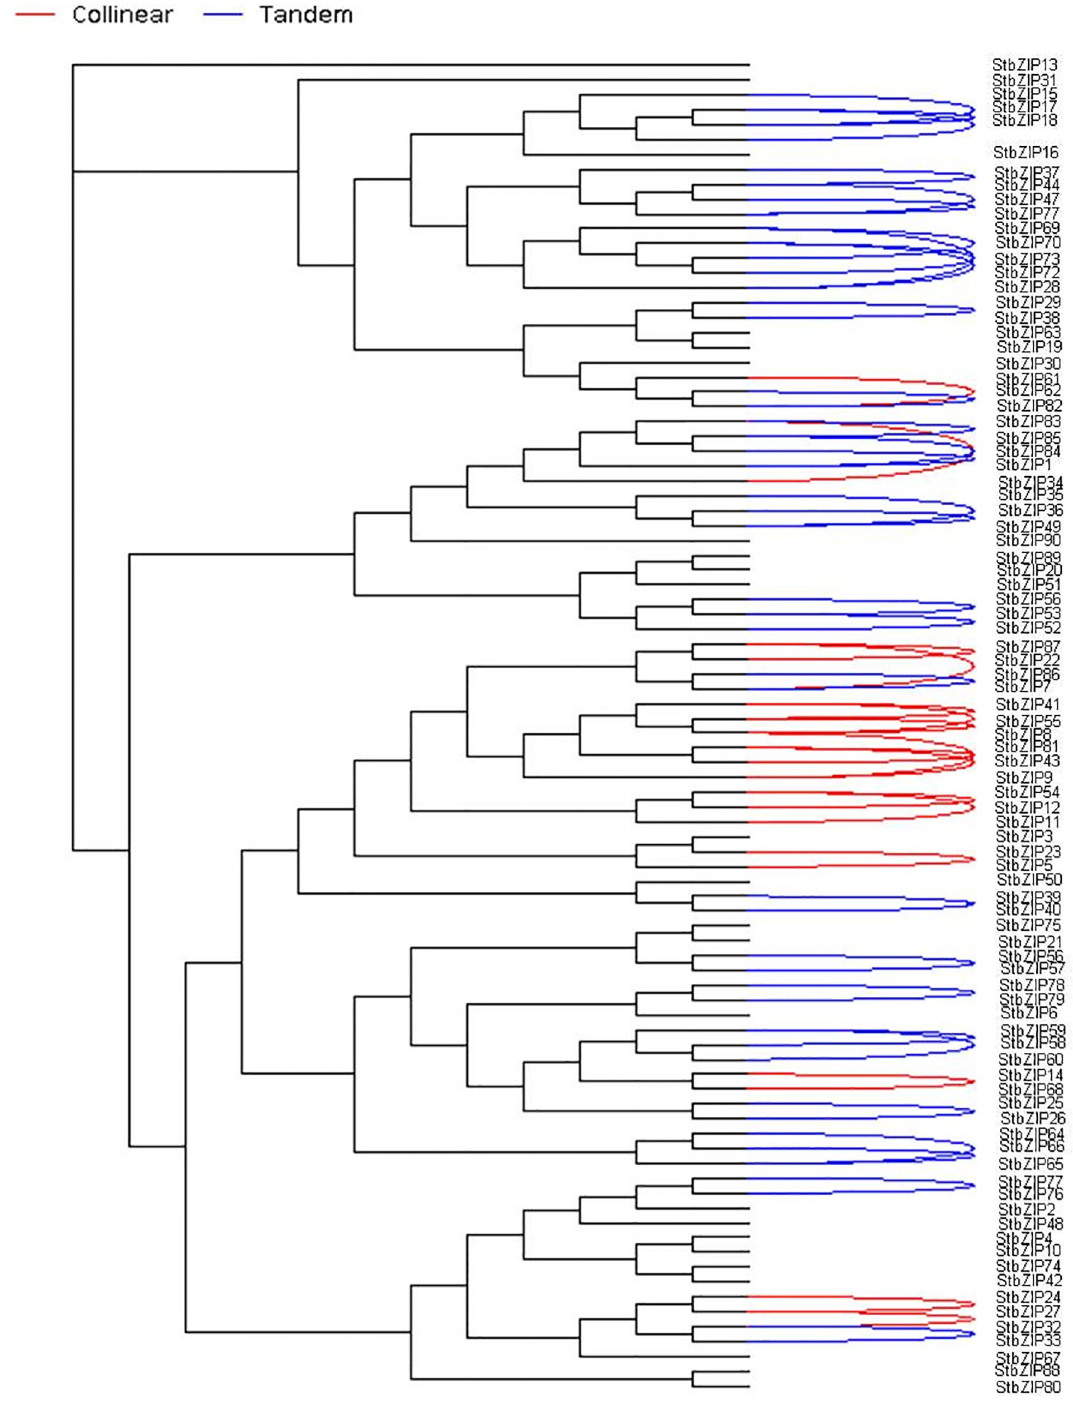
Fig 1. Chromosomal distribution and StbZIP gene duplication events in potato. The chromosomal position of each StbZIP was mapped according to the genome annotation of potato. The segmentally duplicated genes are represented as red lines, and the tandemly duplicated genes by blue